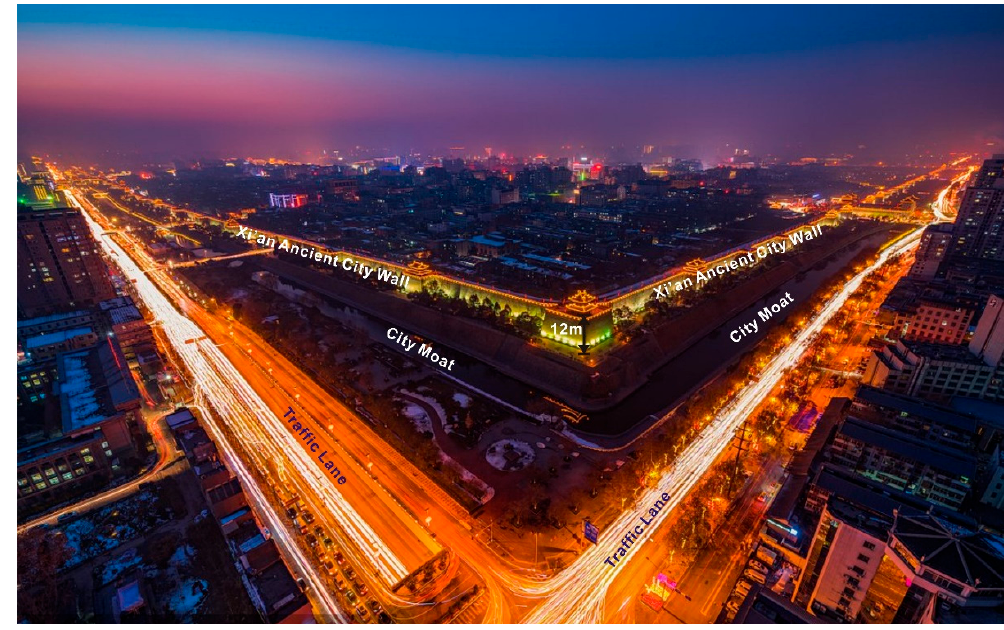
Figure 5. The brake wear contribution ( A ) and the busy transportation map of the Xi’an ancient city wall ( B ). (Picture source from www.vcg.com).